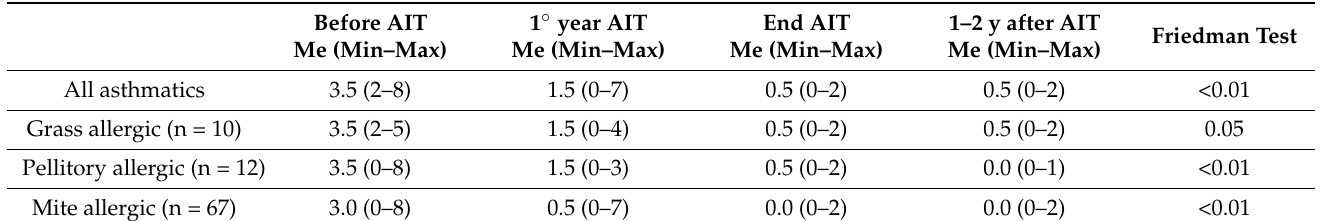
Table 4. Number of asthma exacerbations requiring systemic steroids over the course of treatment.